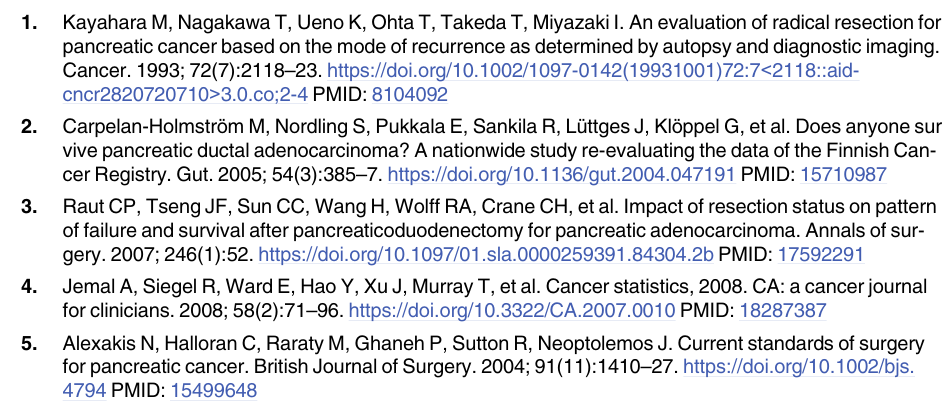
S1 Fig. Comparison of the two types of classification for the resection margin used in this